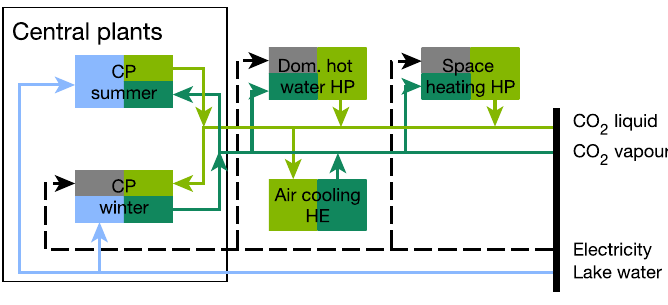
Figure 1. CO 2 network schematic